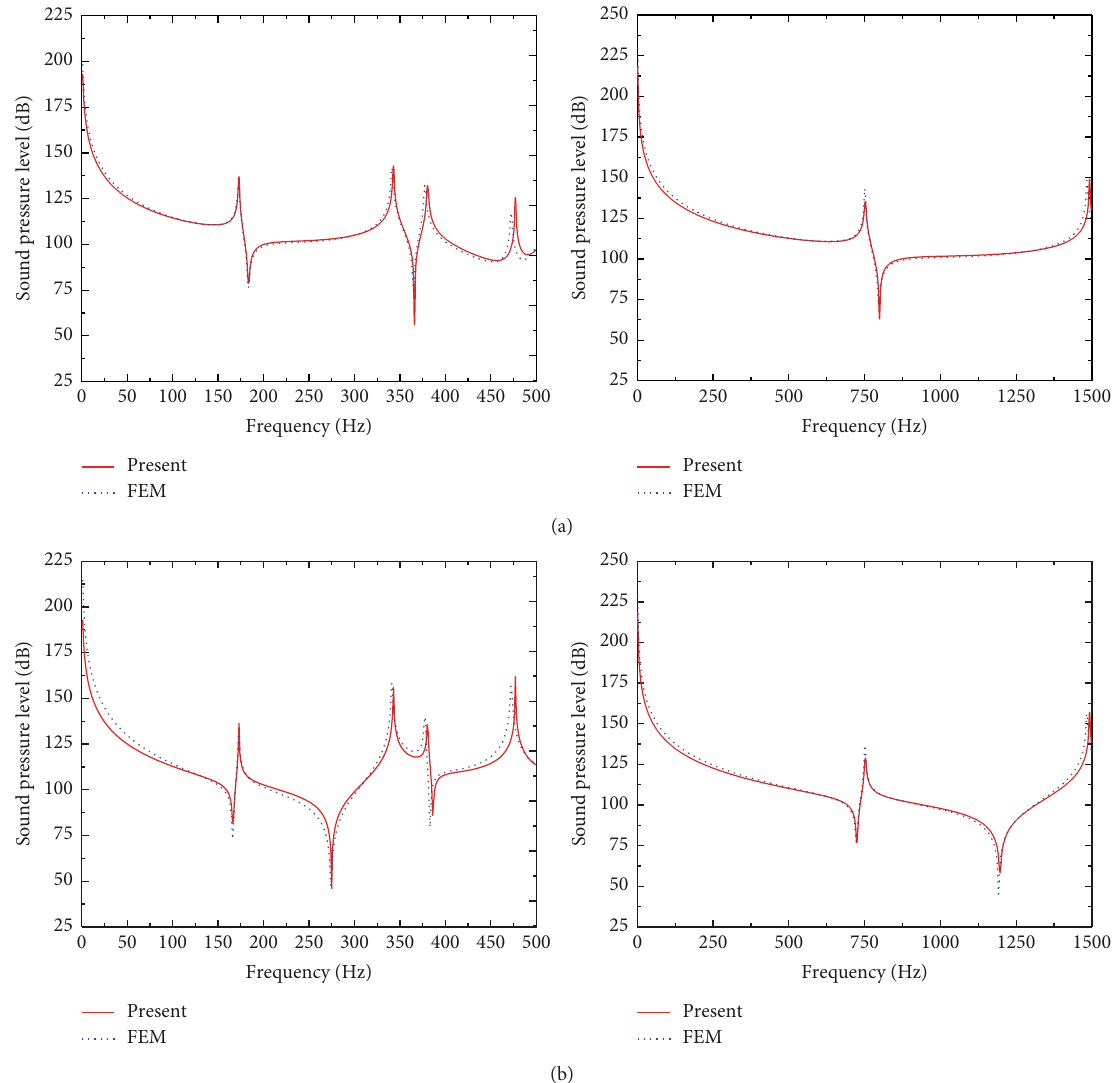
Figure 10: Acoustic pressure response of the quadrangular prism acoustic cavity with rigid walls under the unit point sound source excitation. (a) Observation point 1. (b) Observation point